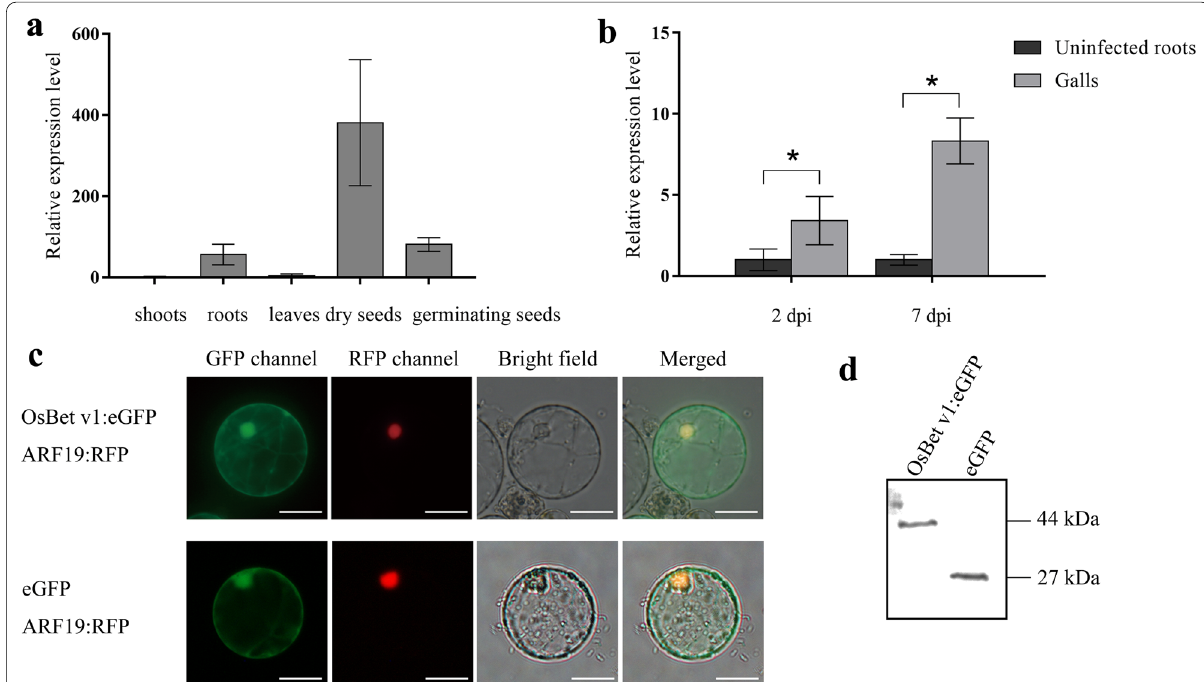
Fig. 3 Expression of OsBet v1 in rice tissues and in response to Meloidogyne graminicola invasion and subcellular localization of OsBet v1. a Expression of OsBet v1 in different rice organs. The level of OsBet v1 transcript at the shoots was set as 1 and used to calculate the relative expression level of this gene in other tissues. b Expression of OsBet v1 in rice roots infected with M. graminicola at 2 and 7 days post-inoculation (dpi). c Subcellular localization of OsBet v1. OsBet v1:eGFP was transformed into rice root protoplasts, with transformation of eGFP alone as the control. ARF19:RFP was used as a nuclear-localized marker. Scale bars: 20 μm. d Western blotting detection of the target proteins extracted from transformed cells. Protein bands with expected size of approximately 44 kDa for OsBet v1:eGFP and 27 kDa for eGFP were observed. eGFP, enhanced green fluorescent protein; RFP, red fluorescent protein. Data are presented as the mean SD. * P < 0.05, Student’s t ±